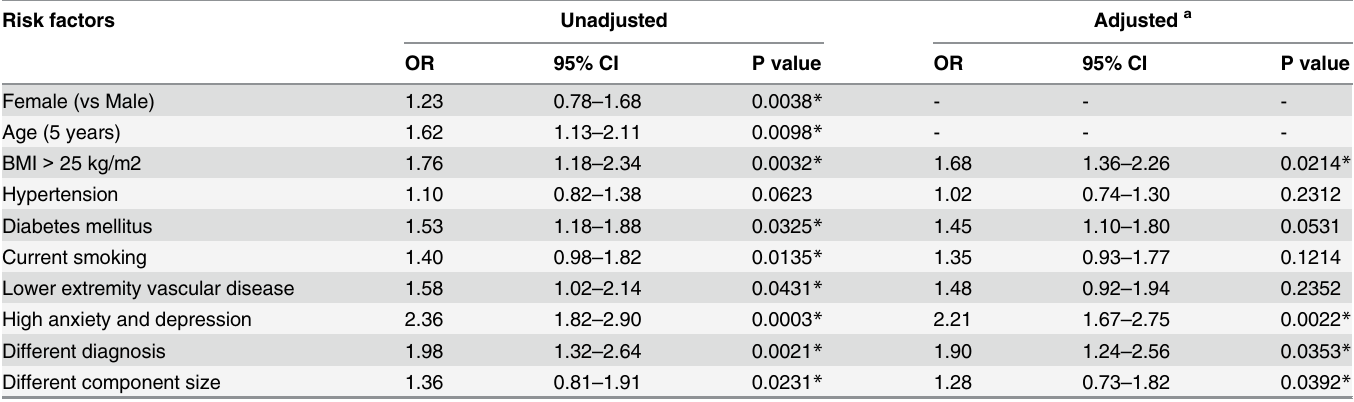
(2) time interval had significant effects on asymmetry between limbs (P = 0.0022),and (3) gen- der/BMI over asymmetry between limbs were not significant (P = 0.0055/0.0213). Discussion Our results suggest that there is significant asymmetric recovery between limbs for SBTKA patients just as there is with staged bilateral TKA and unilateral TKA. The present study pro- vides novel evidence that interlimb difference in clinical outcomes after SBTKA appear early Table 3. Risk factors for inter-limb